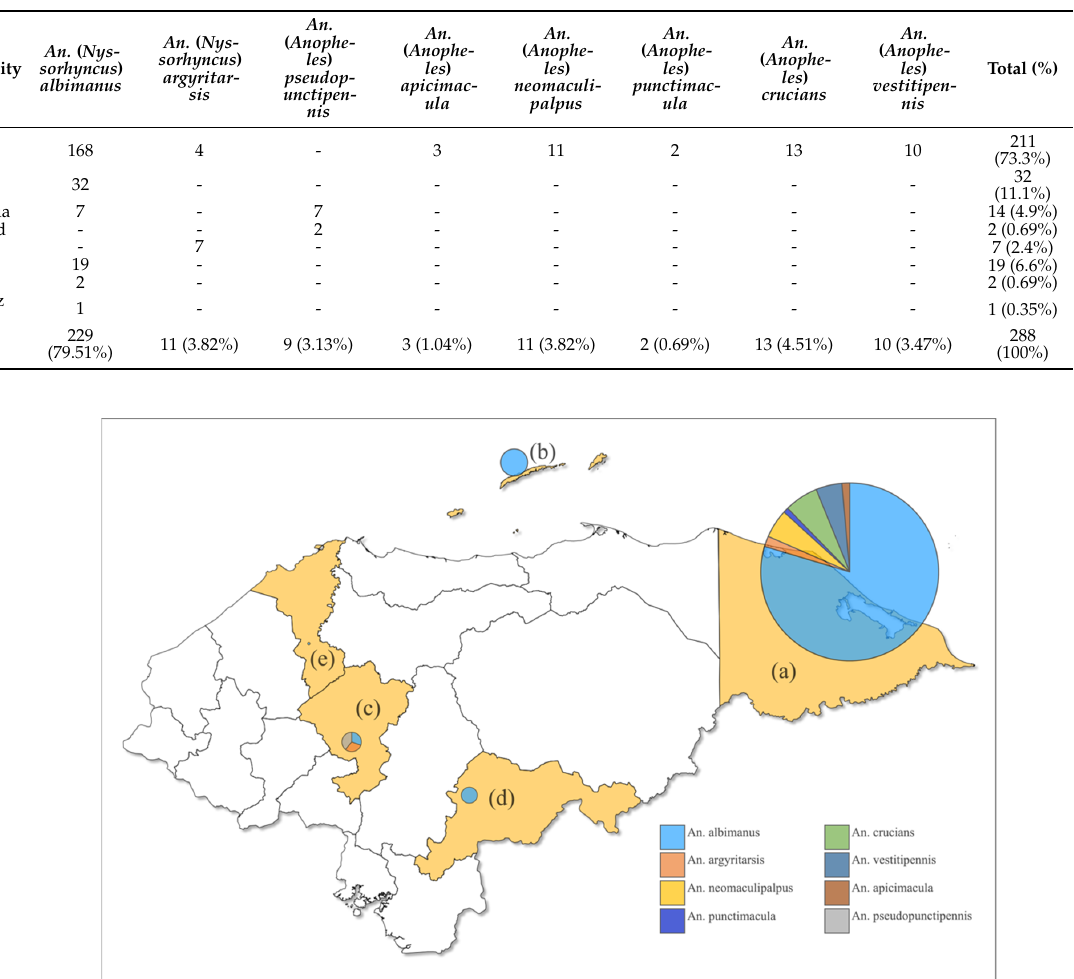
Figure 2. Map of Honduras showing pie charts with the proportion of Anopheles species collected at each department. Chart size is proportional to the number of specimens collected: ( a ) Gracias a Dios; ( b ) Bay Islands; ( c ) Comayagua; ( d ) El Paraíso; ( e ) Cortés.